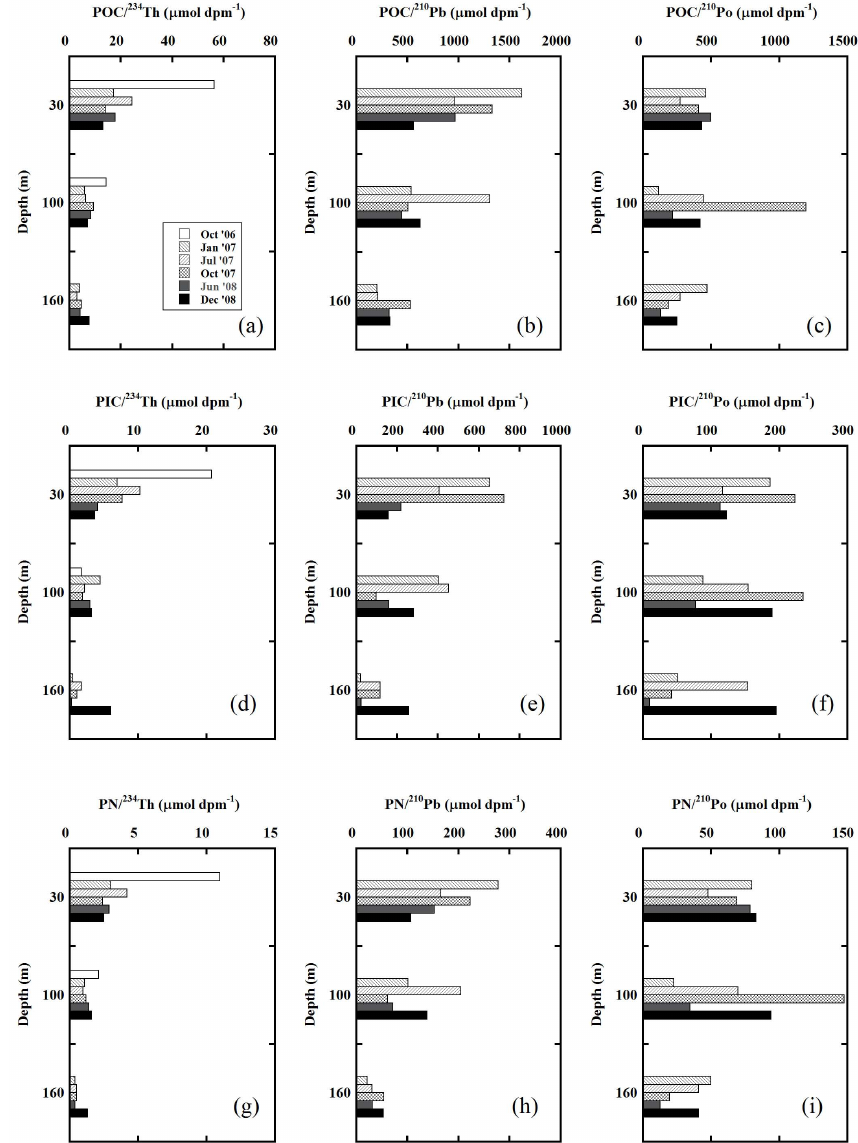
Fig. 7. Ratios of (a–c) POC and RN, (d–f) PIC and RN, and (g–i) PN and RN in settling particles collected by floating traps at the three depths of